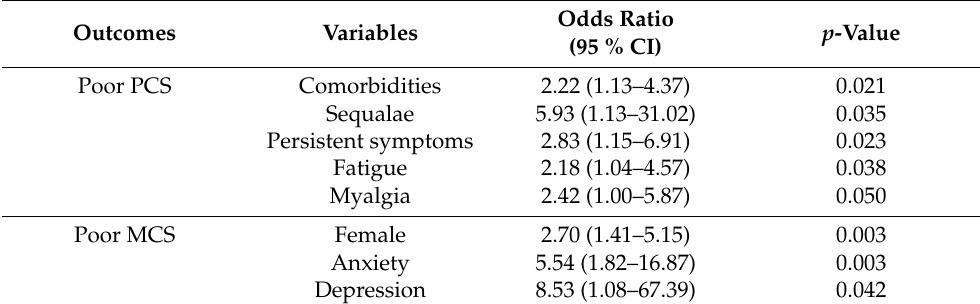
Table 7. Results of multivariate logistic regression for HQRL of COVID-19